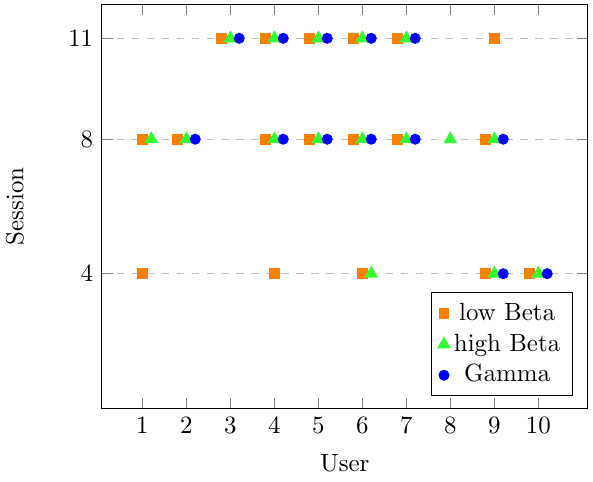
Figure 7. Sessions with significant change in Dataset